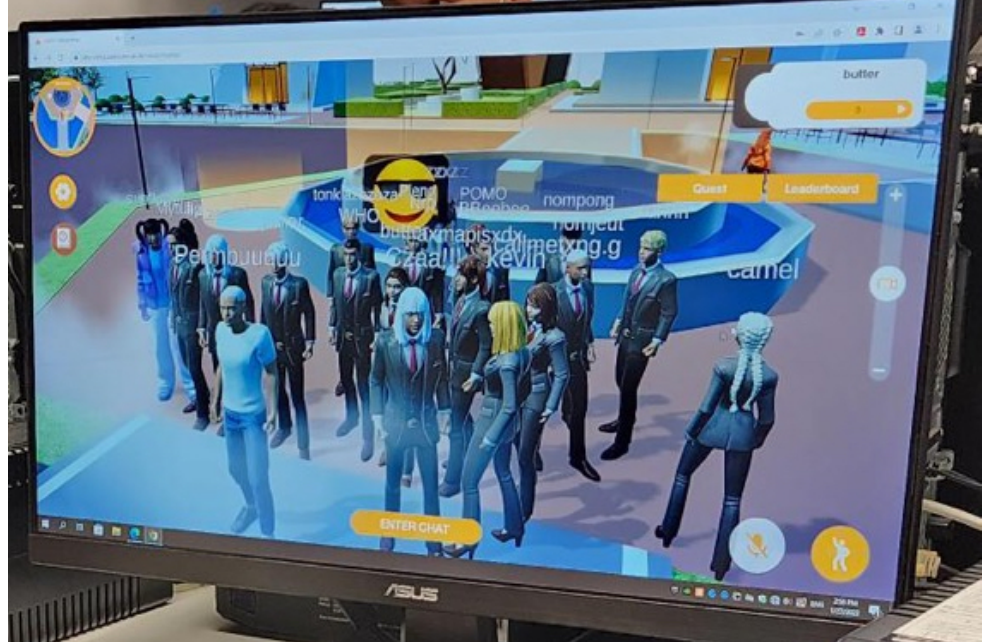
Figure 14. This is a screenshot from one of the participant’s displays that shows the crowded avatars around the fountain during the